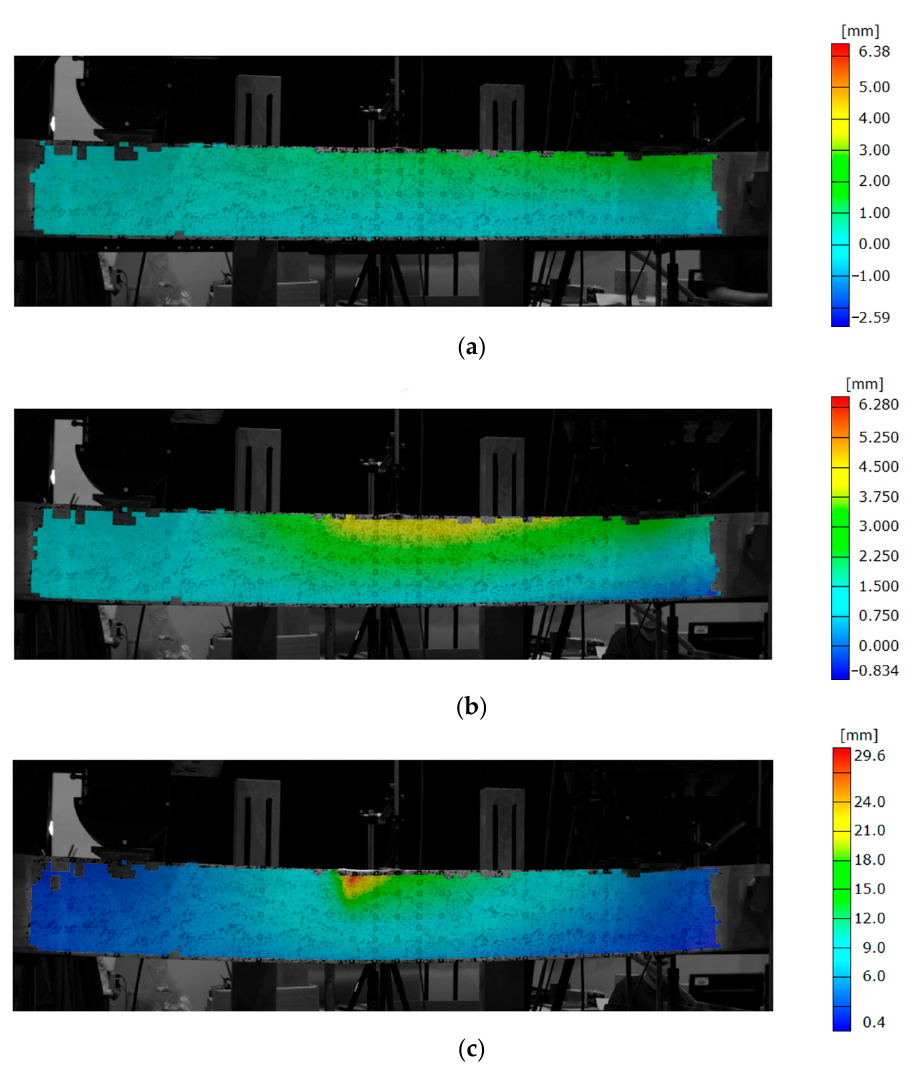
Figure 11. Evolution of lateral displacement of beam, at: ( a ) load equal to 0.5 Fmax; ( b ) failure load Fmax; ( c ) failure propagation.